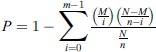
The KEGG pathway analysis of predicted targets differentially expressed miRNAs with P< 0.05.Note: The enrichment p-value calculated by the calculating formula:
P=1−∑i=0m−1(Mi)(N−Mn−i)Nn
N was the number of all genes with KEGG annotation, n was the number of target gene candidates in N, M was the number of all genes annotated to a certain pathway, m was the number of target gene candidates in M.